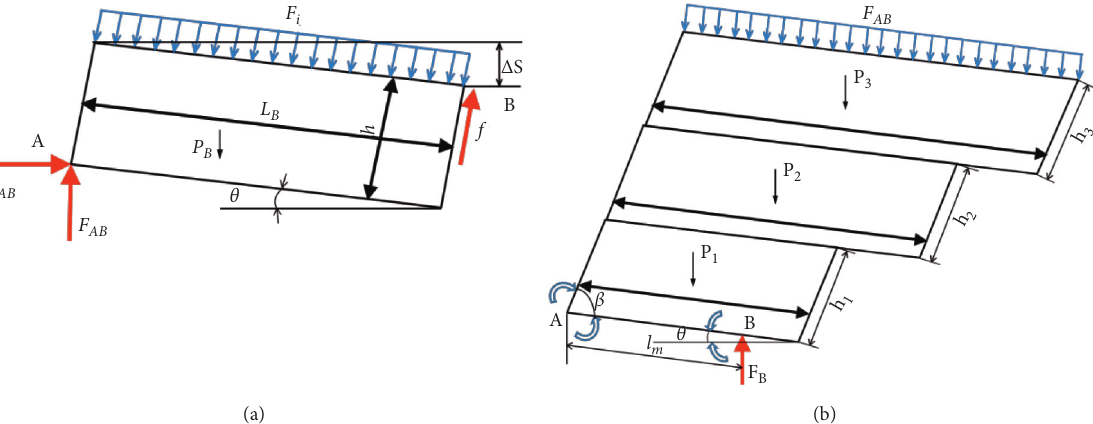
Figure 3: Mechanical model of the key block and cantilever beam. (a) Stress analysis of key blocks. (b) Stress analysis of cantilever structure.